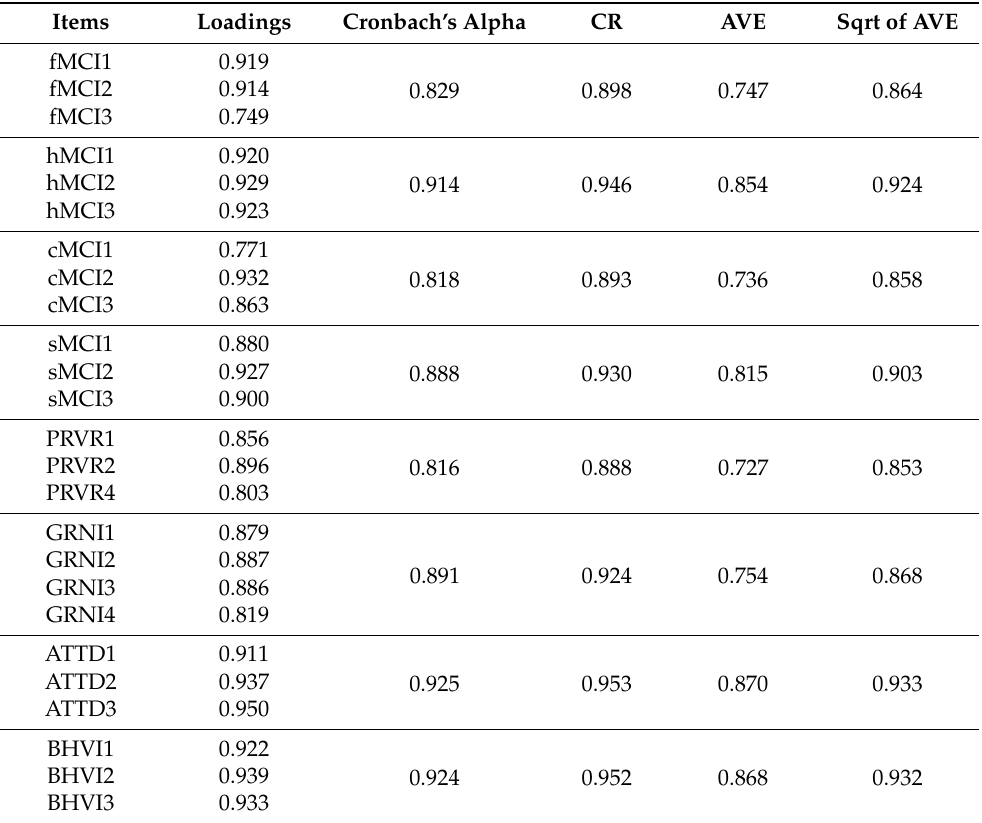
Table 4. Measurement model